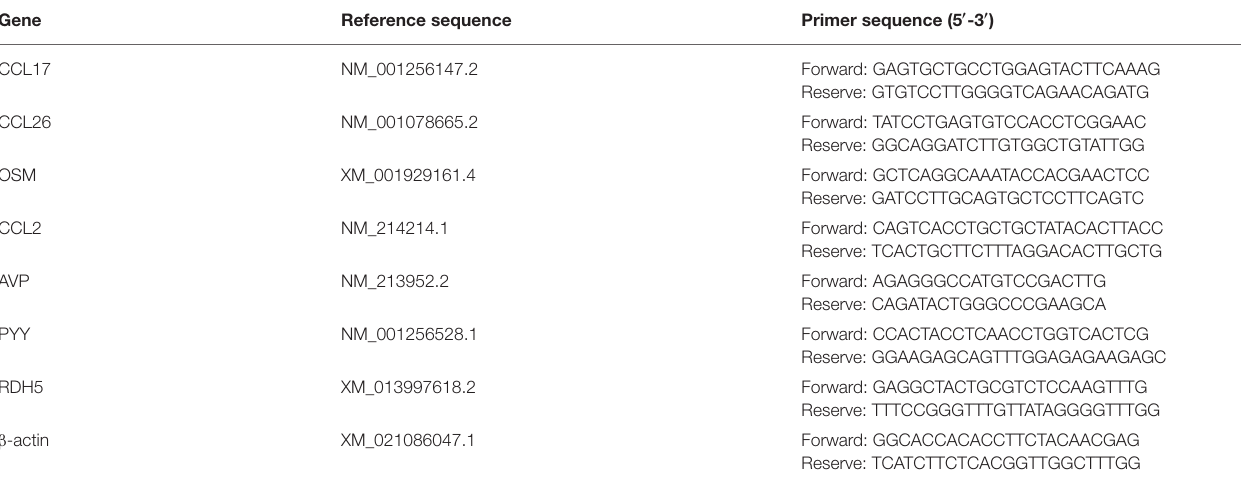
TABLE 2 | Gene sequences used for real-time fluorescence quantitative PCR analysis.